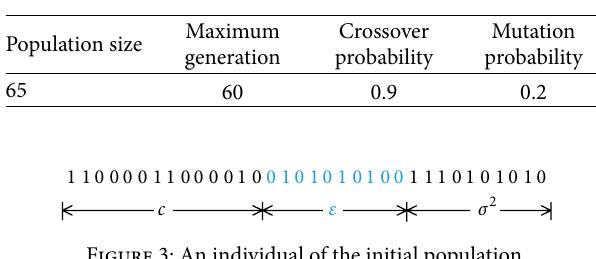
Table 2: GA parameter settings.